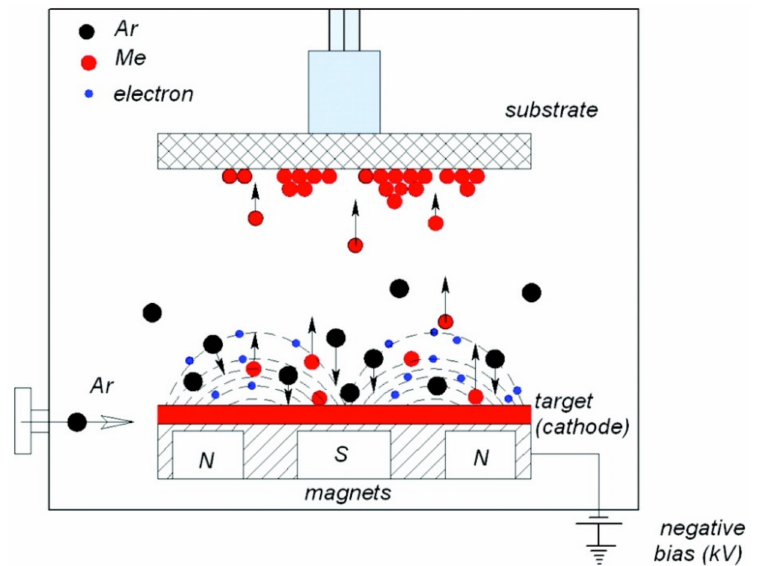
Figure 3. Schematic of magnetron sputtering. Me refers to the metal used as a target, while N and S refer to the poles of the magnetron unit. Reprinted with permission from